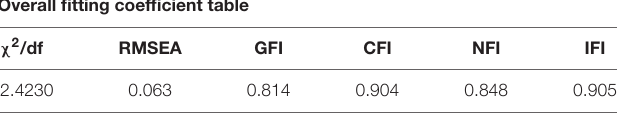
TABLE 4 | Model fit values. Overall fitting coefficient table